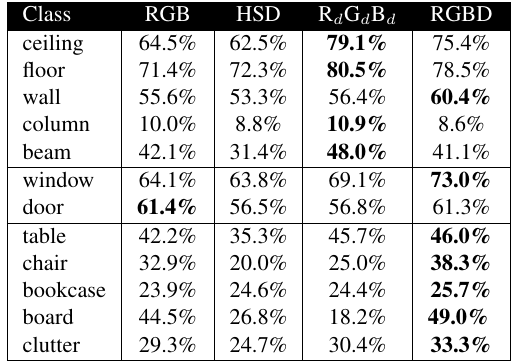
Table 5. Results on semantic labeling in test T2 (10% of the dataset for training and 90% for testing).